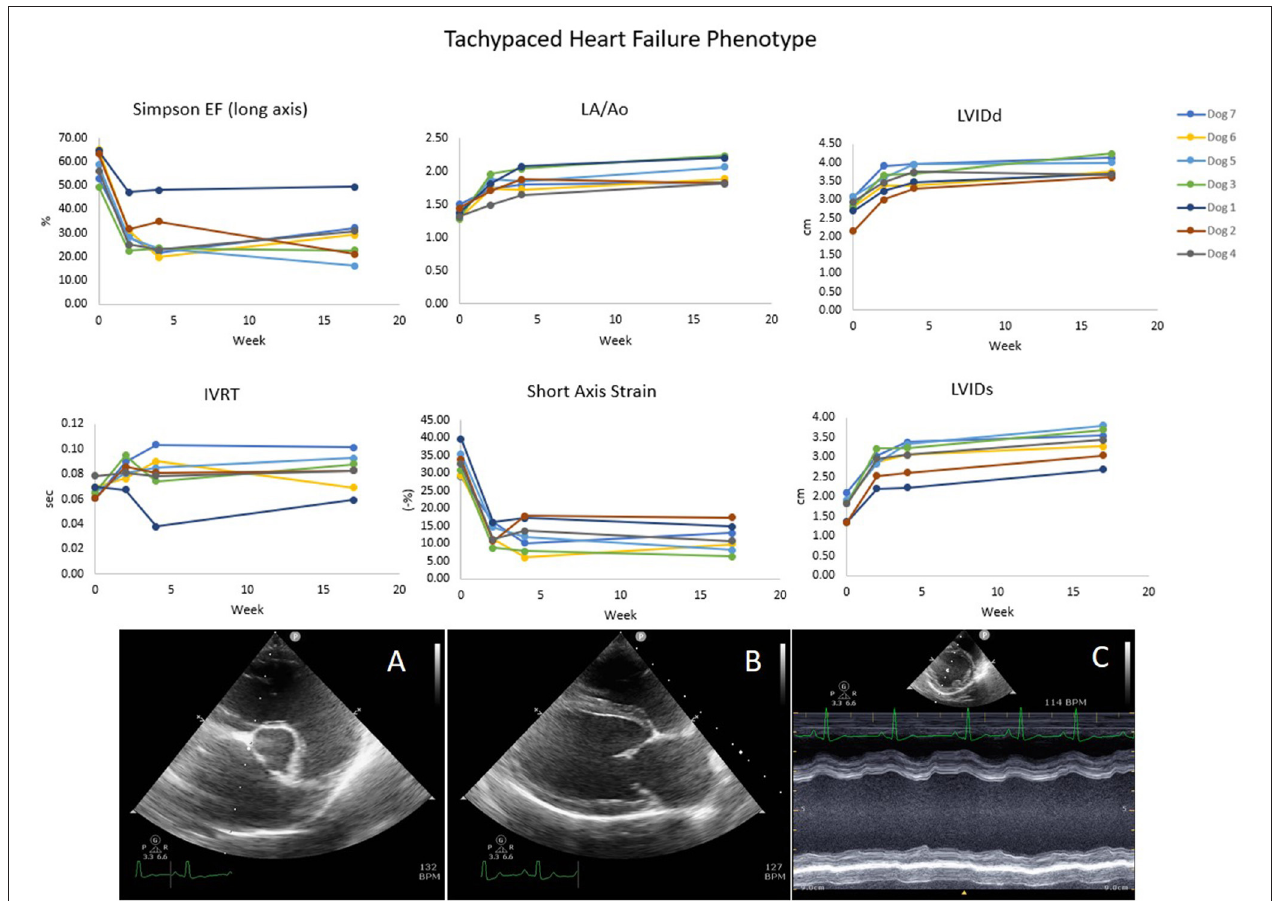
FIGURE 1 | The Tachypaced heart failure phenotype shows decreases in ejection fraction (EF), and strain and increases in IVRT, LA size, and left ventricular diameter. IVRT, isovolumetric relaxation time. (A) Right short axis basilar LA:Ao view. (B) Right long axis view used for Simpson’s EF. (C) Right short axis view used for M-mode.